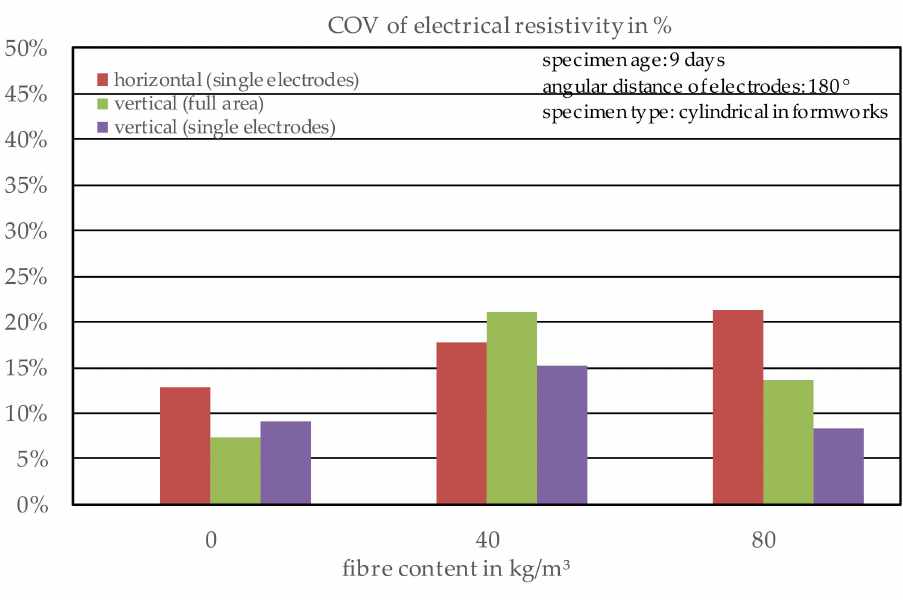
Figure A2. Coefficient of variation of the electrical resistivity in different directions depending on the fibre content at a specimen age of 9 days and an electrode array with angular distances of 180 ◦